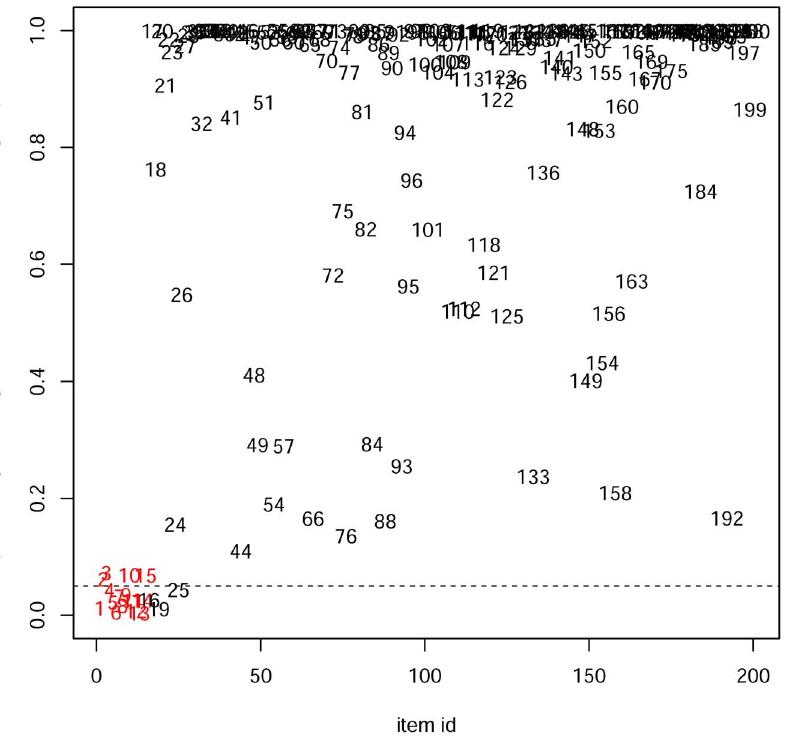
Figure 3. LFDR plot for simulation data of the Case group and the Control group. Integers in red indicate potential biomarkers and integers in black indicate other markers. 0.05 (dash line) is treated as the threshold for potential biomarkers identification. The integers below the dash line are identified as potential biomarkers.